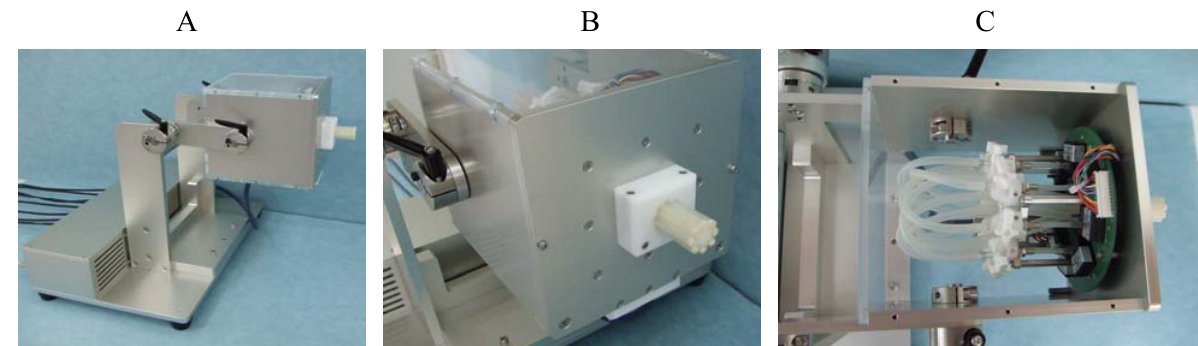
Figure 3. Apparatus for measuring multidirectional lip-closing force using air pressure sensors. A: overview, B: probe, C: inside of the sensing box. Changes in air pressure detected in the probe are measured by eight pressure sensors located in the sensing box.